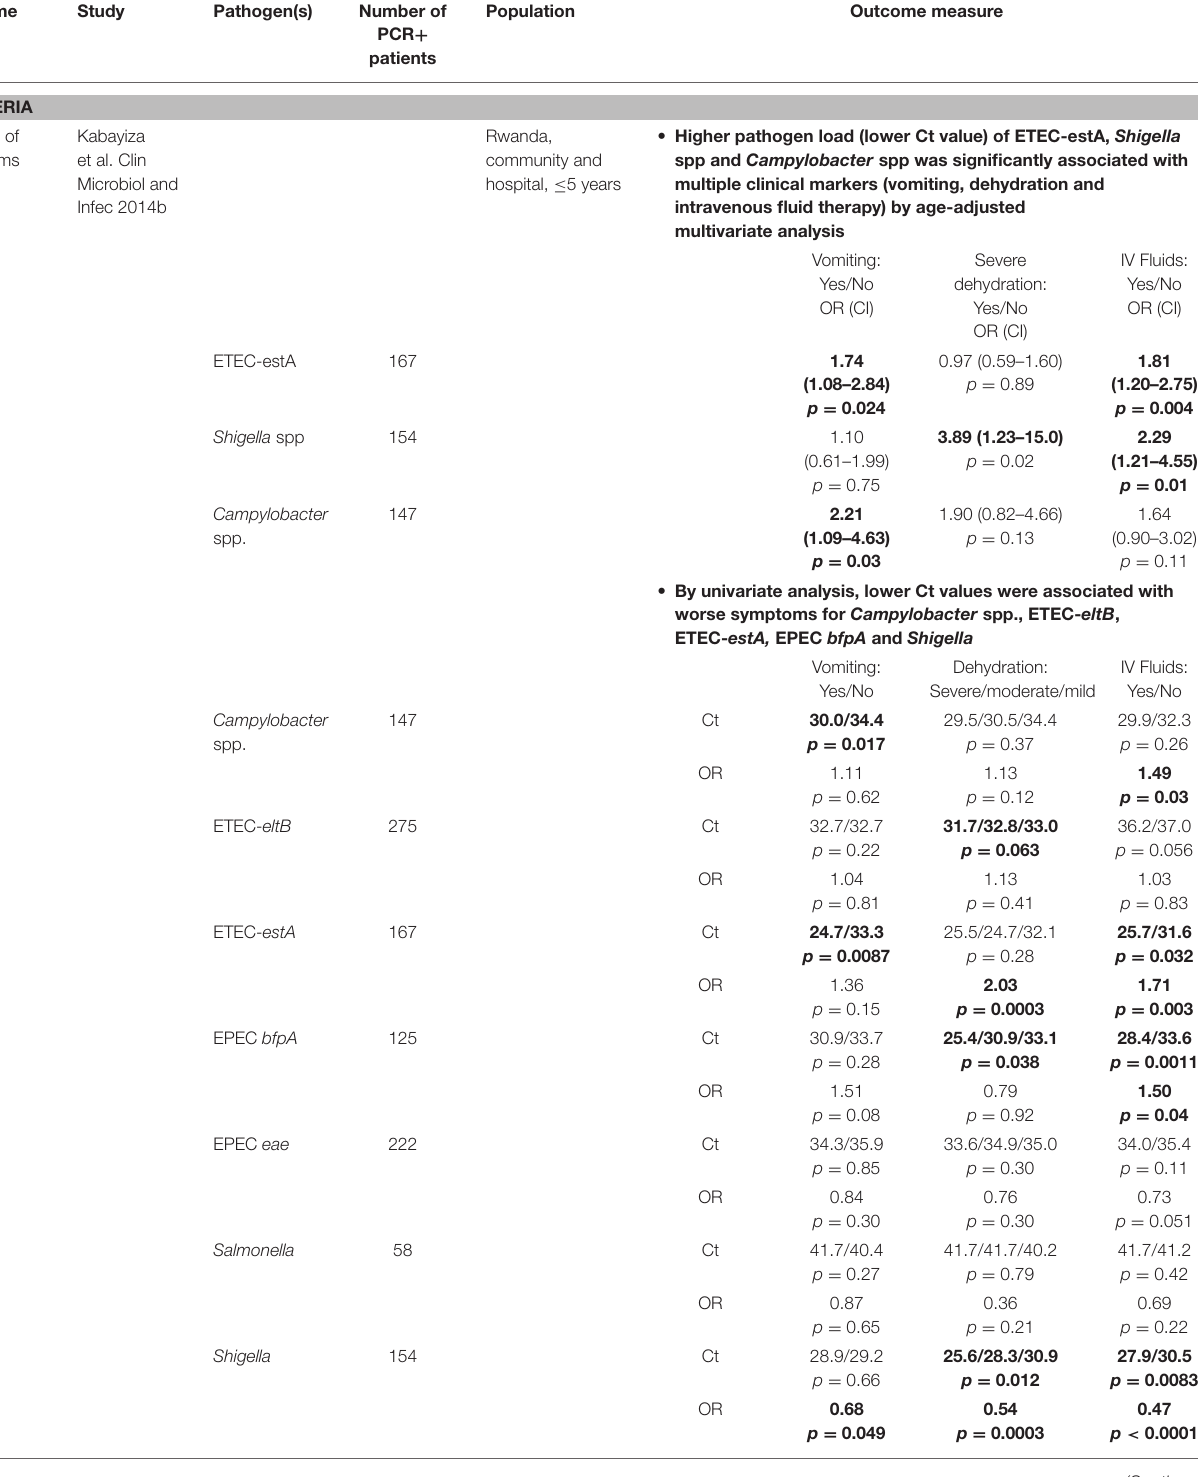
TABLE 3 | Summary of studies that assessed PCR Ct values for non- C. difficile bacterial and parasitic pathogens against patient clinical presentation and outcomes.